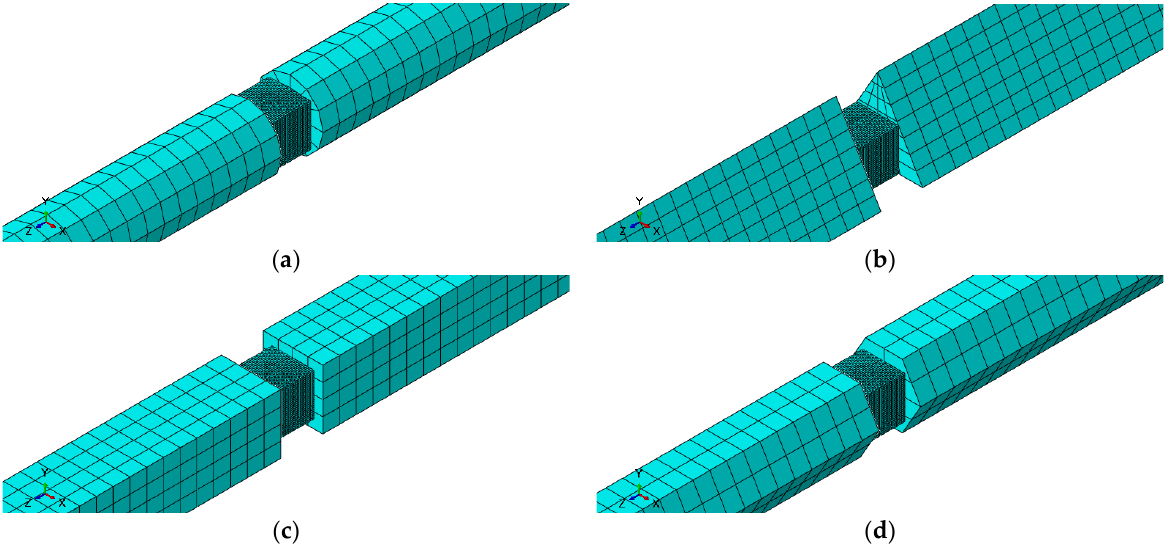
Figure 6. Mesh procedure. ( a ) Circle, ( b ) triangle, ( c ) square, ( d )